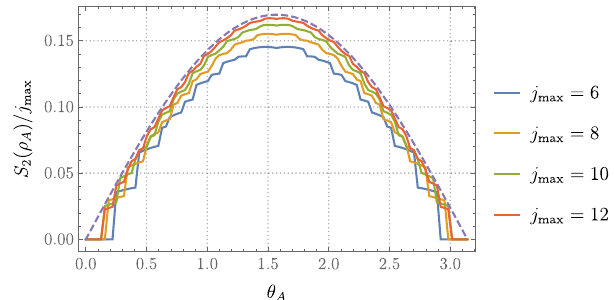
FIG. 10. The second R´enyi entropy for a complex scalar free field (with mass μ ¼ 1 ) versus the polar angle θ cap. The entropy with different cutoffs j j , the curve approaches the boundary law 0 . 03 × 2 π sin θ max shown as a dashed line. Discreteness in the plot is again due to the finite j space of max